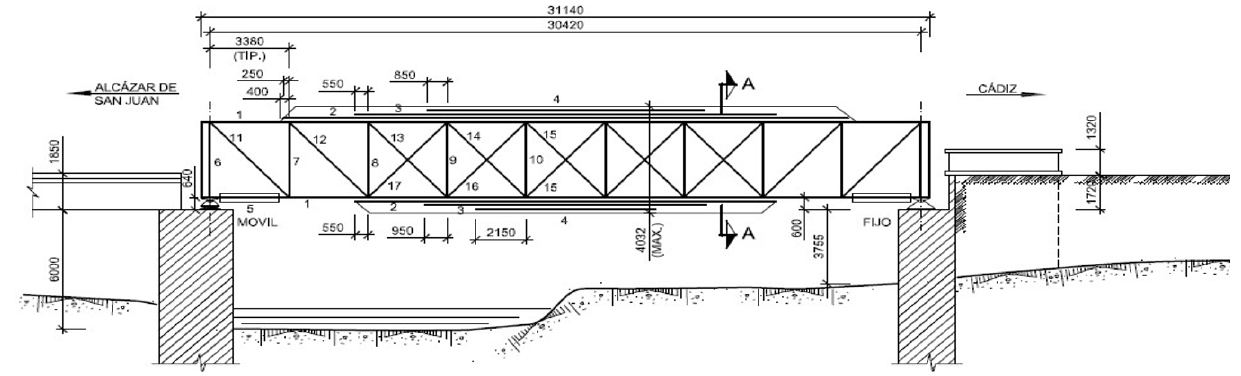
Figure 2. “Arroyo Corbones” elevation sketch (dimensions in mm).